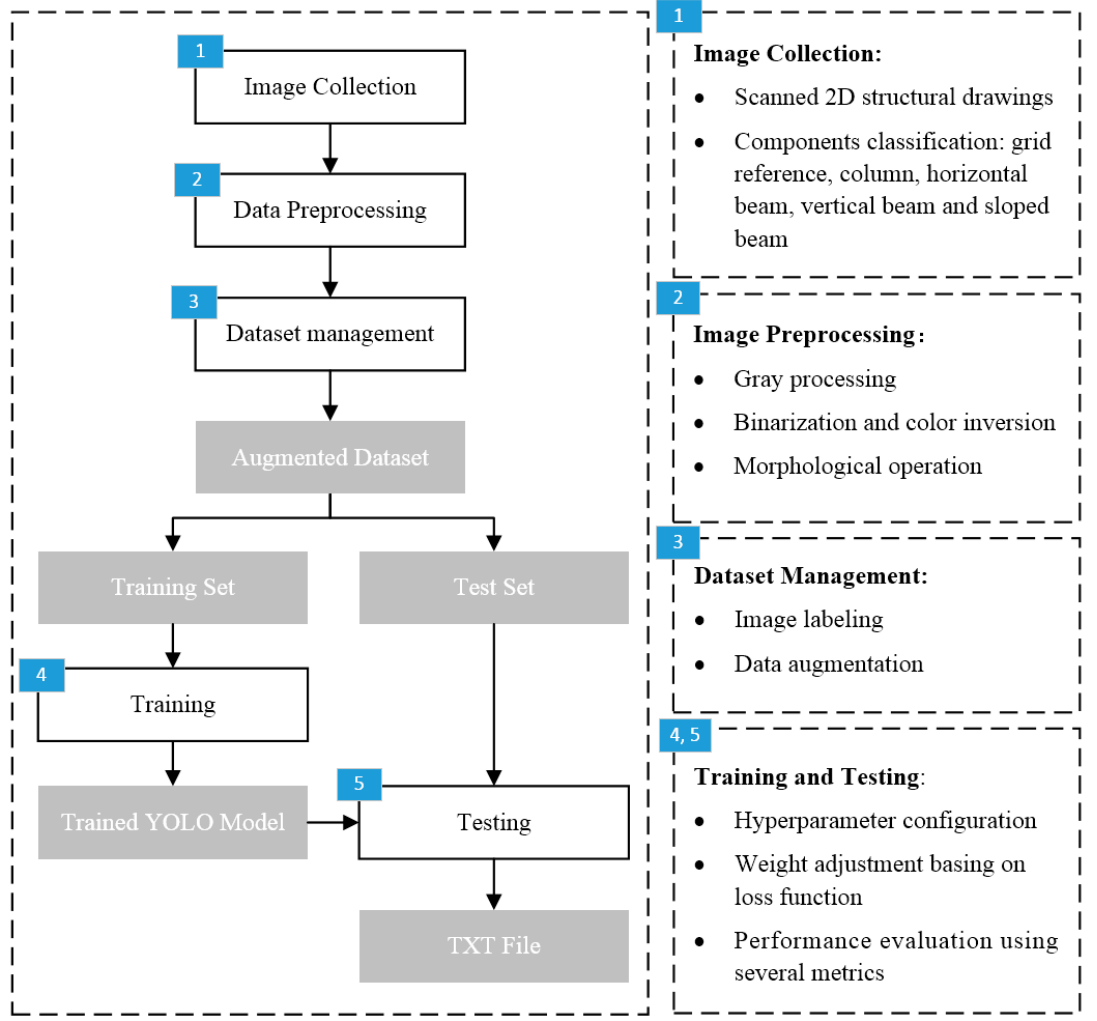
Figure 1. Overall process of YOLO-based component detection method.